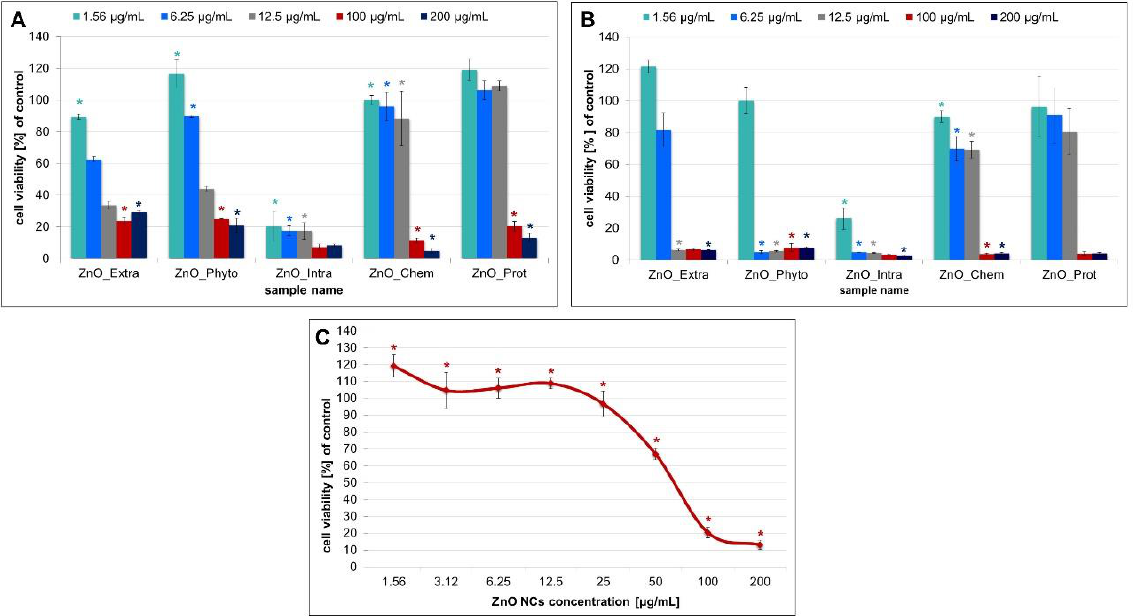
Figure 3. The MTT assay results and effects of indicated concentrations of bare and functionalized ZnO NPs on the ( A ) Caco-2 cells and ( B ) L929 cell viability. ( C ) the effect of different concentrations of biochemically synthetized ZnO NPs against the Caco-2 cell line. The values are expressed as mean ± SD values of three independent experiments ( n = 3); * p < 0.001 compared to bare ZnO NPs (ANOVA).